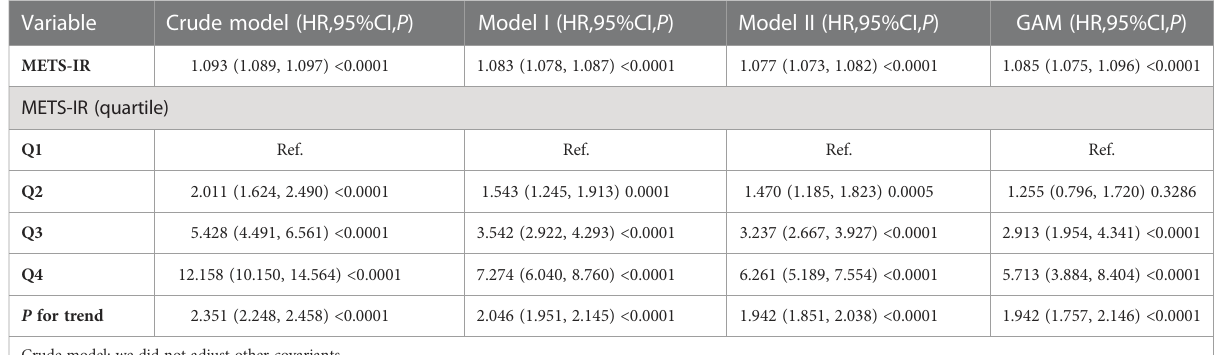
TABLE 3 Relationship between METS-IR and the incidence of diabetes in different